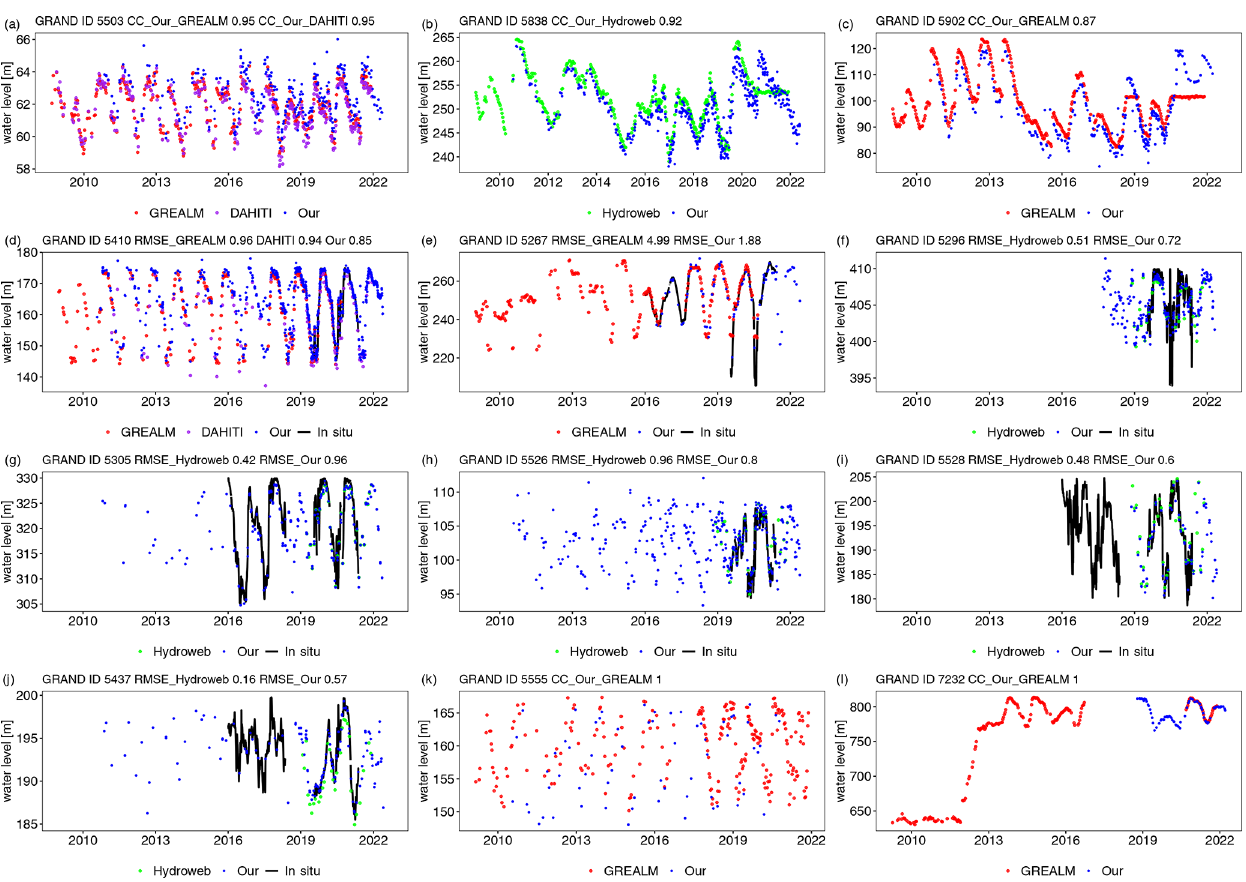
Figure 6. Multiproduct evaluation at p27 reservoirs (15 reservoirs are shown in Fig. C1). DAHITI is plotted in black, G-REALM in red, Hydroweb in green, our dataset in blue, and in situ records with a black line. RMSE values are given when in situ observations are available; otherwise, CC values are given at the top of each subplot. Panels (a) – (l) are the Zhelin, Fengman, Shuifeng, Three Gorges, Xiaolangdi, Shiquan, Ankang, Wuqiangxi, Fengtan, Geheyan, Zhexi, and Nuozhadu reservoirs,